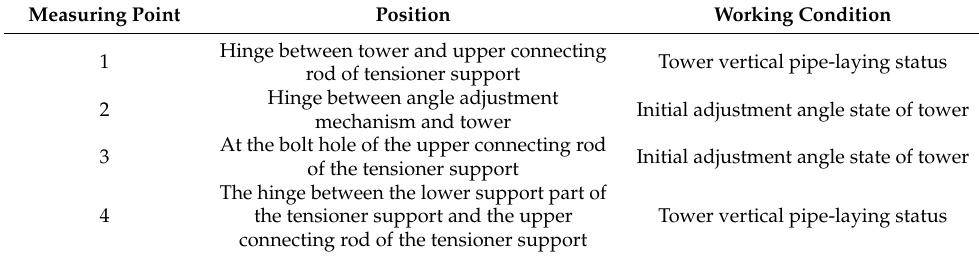
Figure 22. Maximum tension required for tensioner support under various sea conditions. Table 7. Stress detection points of the scaled model.